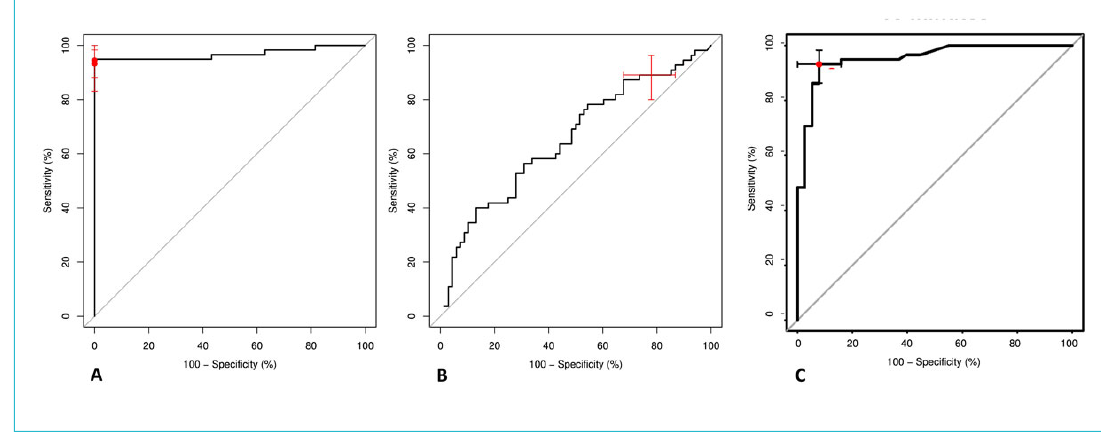
Figure 3: Receiver operating characteristic (ROC) curves for the hypertonic saline infusion test, the indirect water deprivation test and the arginine infusion test(A) ROC curve for hypertonic saline stimulated copeptin levels for discriminating patients with primary polydipsia from pa- tients with central diabetes insipidus. ROC area under the curve = 0.968 (95% confidence interval [CI] 0.931−1.00). Copeptin cut-off levels 4.9 pmol/l (predefined) and 6.5 pmol/l (post-hoc derived) are indicated. Data according to Fenske et al [47].(B) ROC curve for change in urine os- molality before and after injection of desmopressin during the water deprivation test for discriminating patients with primary polydipsia from pa- tients with central diabetes insipidus. ROC area under the curve = 0.654 (95% CI 0.556−0.753). 95% CIs are indicated for the cut-off 9%. Data according to Fenske et al [47].(C) ROC curve for arginine infusion-stimulated copeptin levels for discriminating patients with primary polydipsia from patients with central diabetes insipidus. ROC area under the curve = 0.95 (95% CI 0.91−0.99). Copeptin cut-off level 3.8 pmol/l is indicat- ed. Data according to Winzeler et al